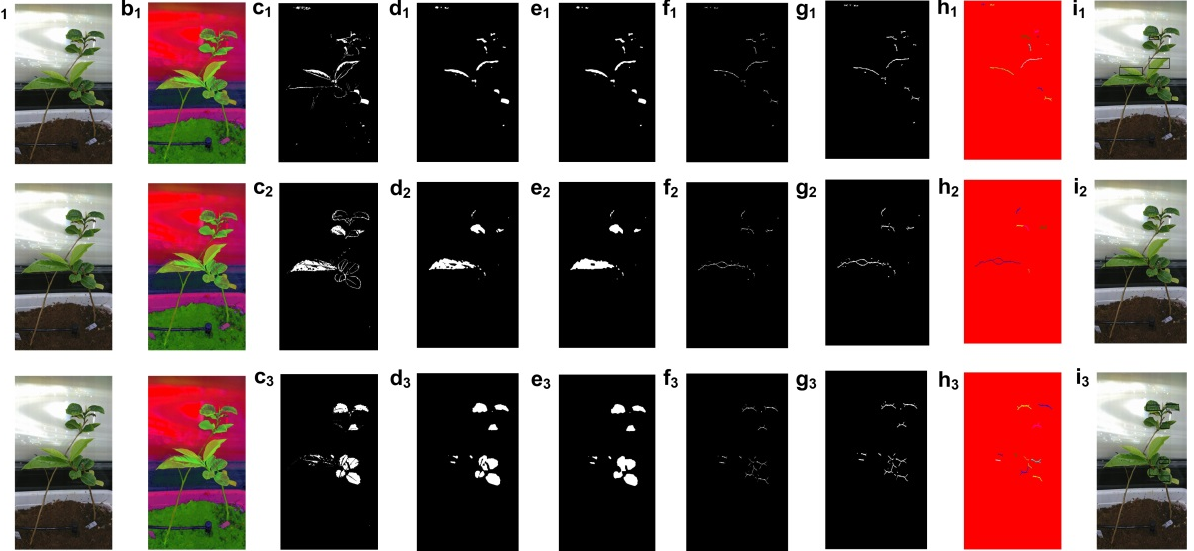
Figure 11. An example of trait extraction of tea plant images in morphological operations: ( a 1 ) and ( b 1 ) are the original and HSV samples, respectively. ( c 1 − c 3 ) are the binarization operation results of different colour values of the H layer of ( b 1 ) sample. The upper, middle, and lower parts of the figure are the segmentation results of light green, normal green, and dark green, respectively. All three images were subjected to morphological operations to remove the stems and branch stems of tea plants. ( d 1 − d 3 ) Erosion; ( e 1 − e 3 ) closure; ( f 1 − f 3 ) thinning; ( g 1 − g 3 ) Canny edge detection; ( h 1 − h 3 ) eight-neighbour connectivity; ( i 1 − i 3 ) object labelling. Table 2. Performance evaluation of detection of number of leaves for tea plants (Taicha No. 8 and No.